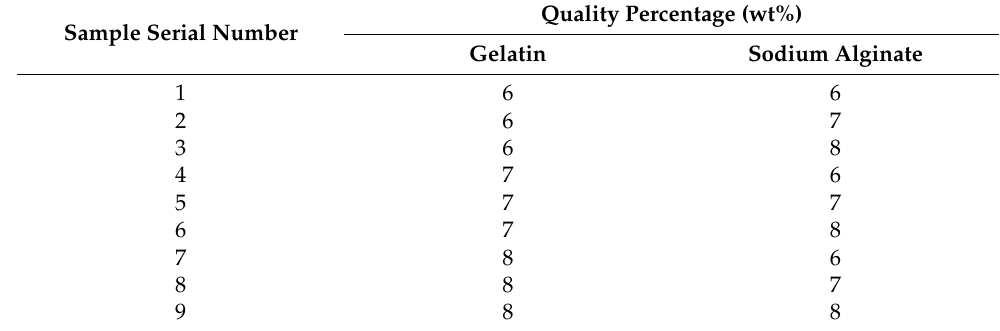
Table 4. Material parameters ( n =